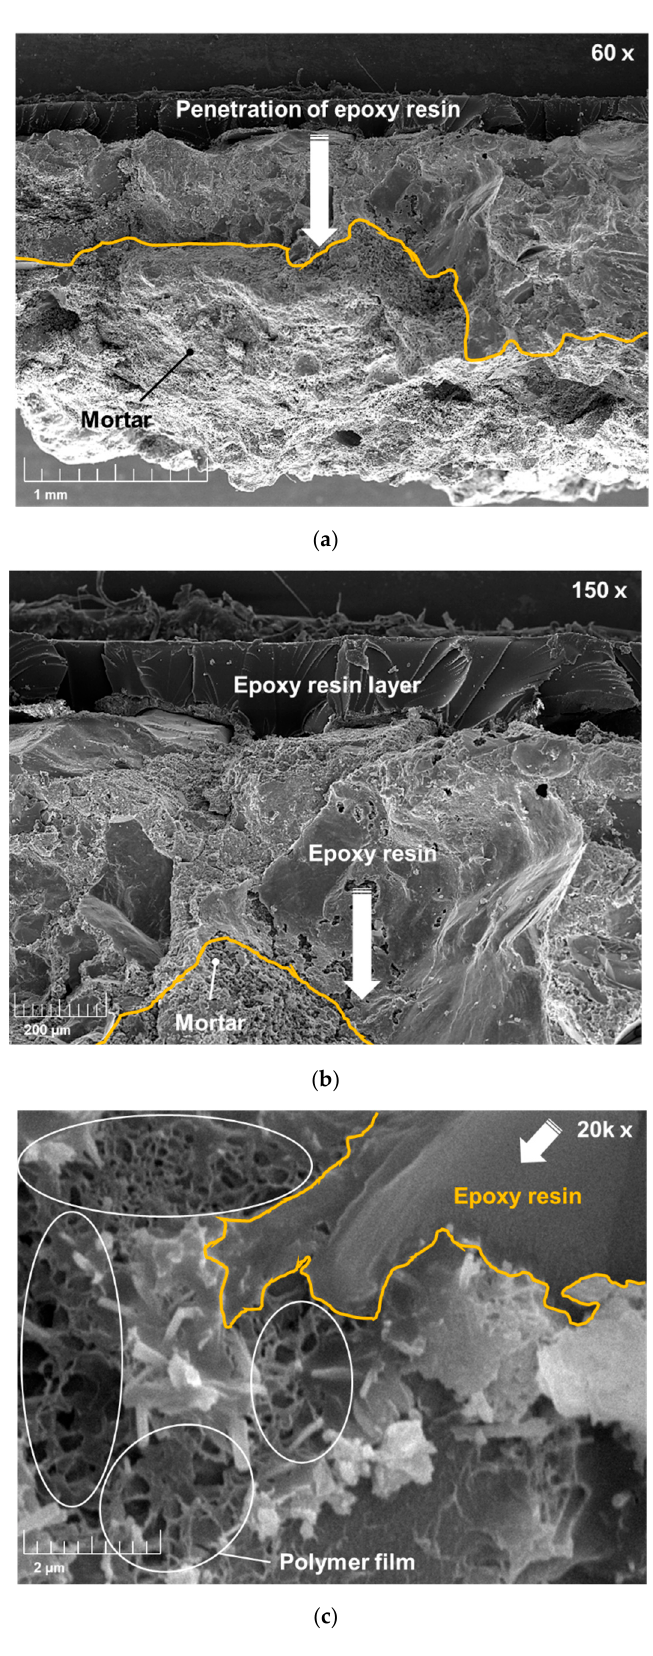
Figure 10. Penetration status of epoxy resin inside the mortar: ( a ) 60 ×, ( b ) 150 ×, and ( c ) 20k ×.